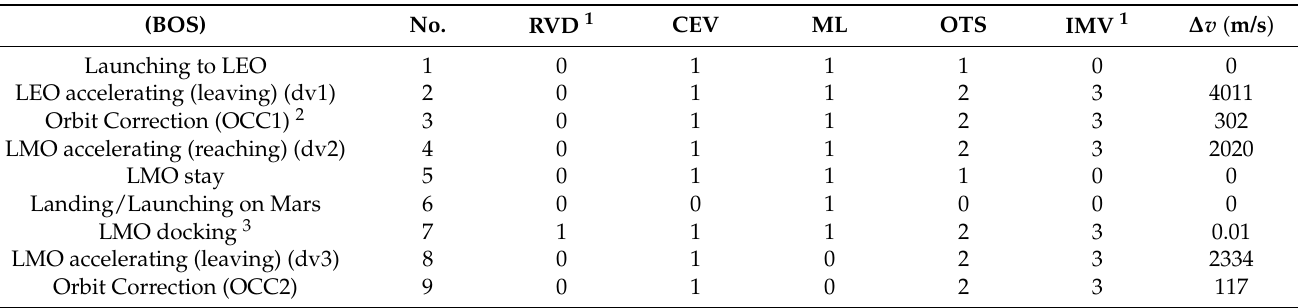
Table 5. Mission architecture matrix of